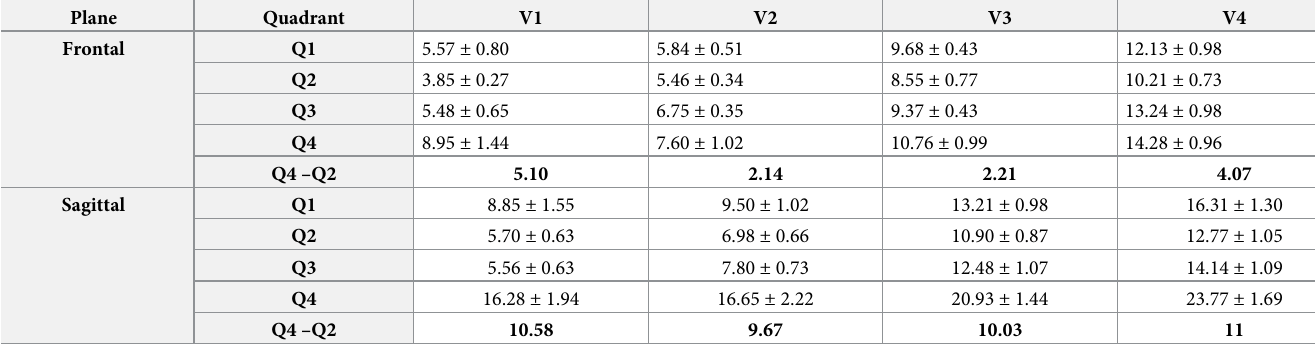
Table 3. Average Δ R values between the target and the tracer, and standard deviation of Δ R .